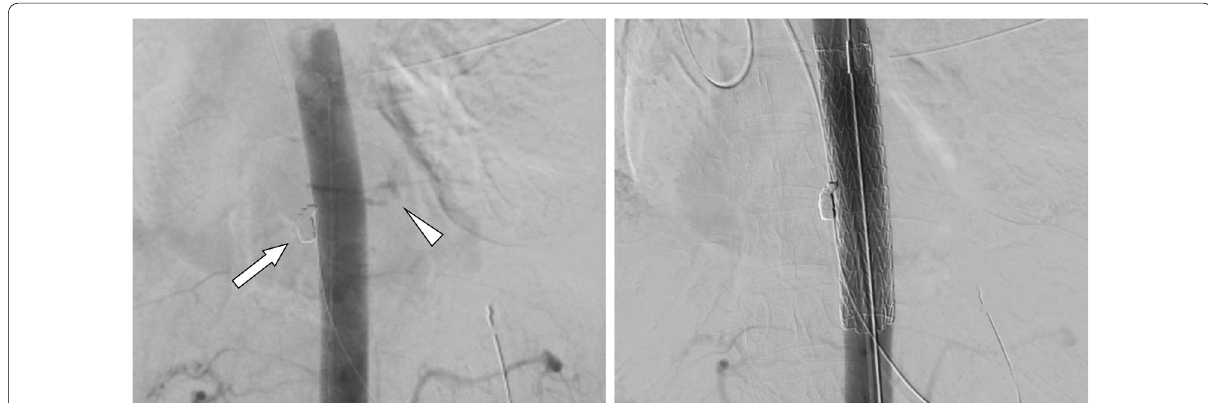
Fig. 2 Computed tomography findings after transcatheter embolization and thoracic endovascular aortic repair. Digital subtraction angiography showing the coil placed during transcatheter arterial embolization (arrow) and extravasation of contrast medium adjacent to the descending aorta (arrowhead) (right). After deploying the thoracic aortic stent-graft, the extravasation disappeared